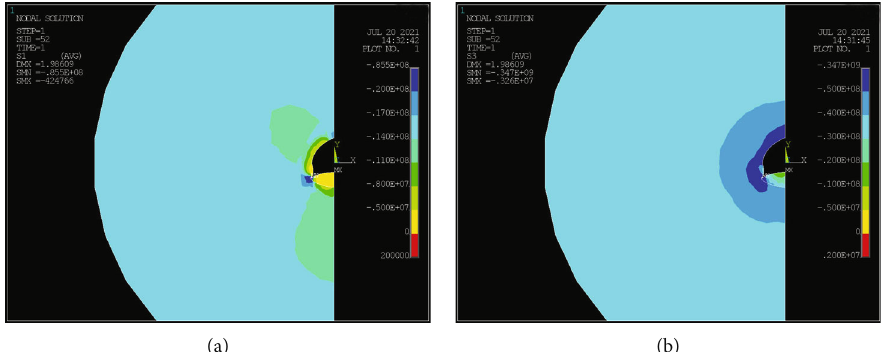
σ 3 ) (b) principal stresses around a roadway with a